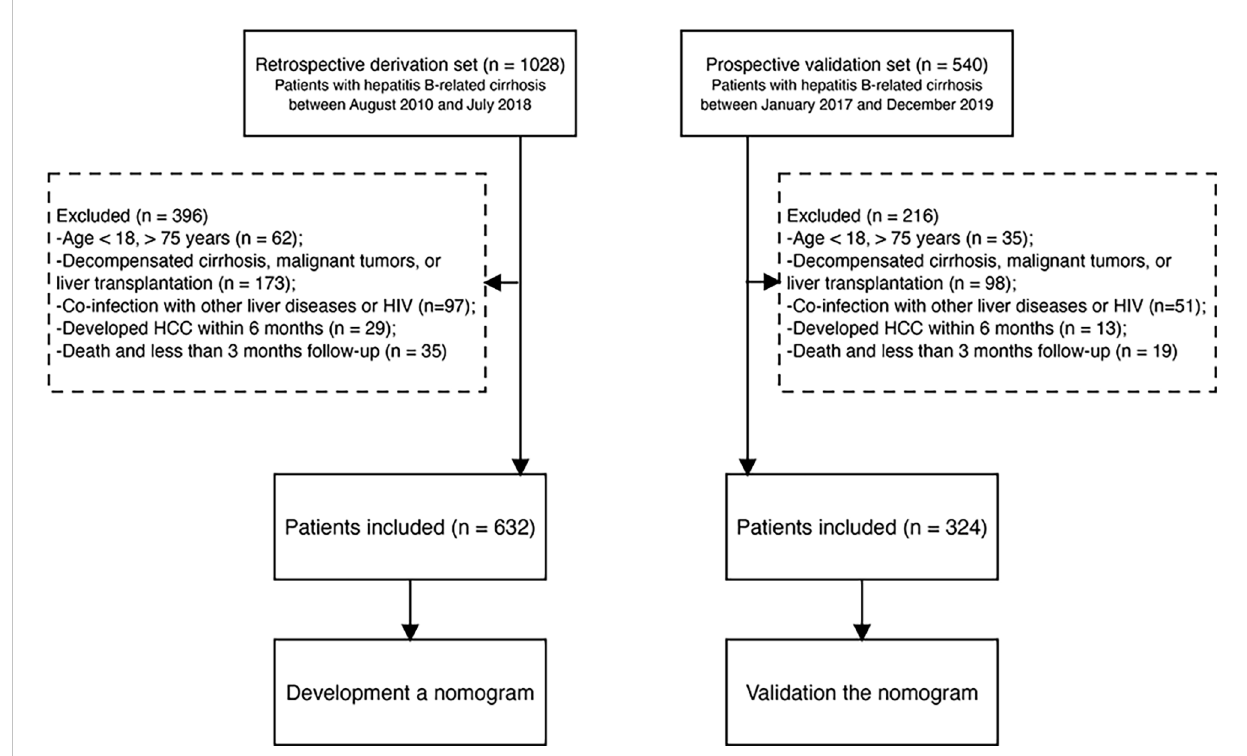
FIGURE 1 Study fl ow diagram. HBV, hepatitis B virus; HCC, hepatocellular carcinoma; HIV, human immunode fi ciency